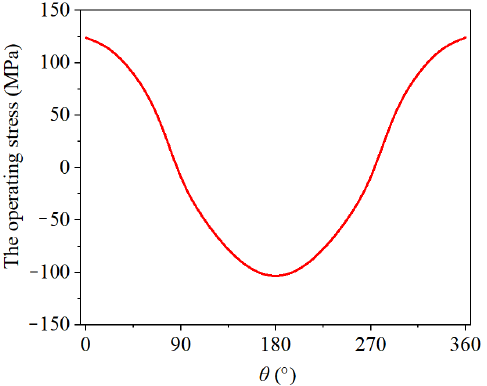
Figure 13. Nominal stress history at point A at the bottom of the rim groove.